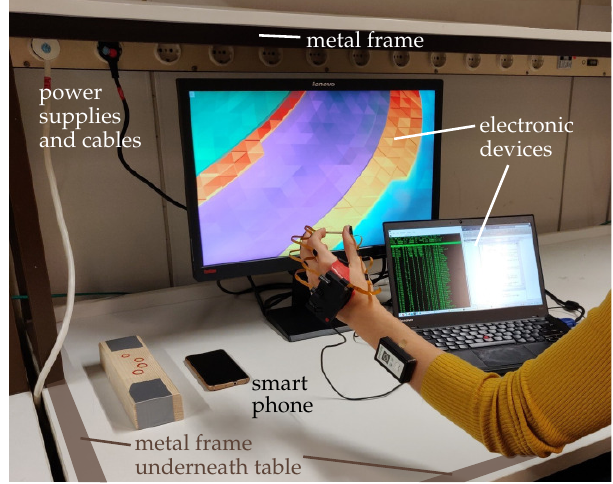
Figure 9. Measurement setup for Setting 2 in the direct presence of ferromagnetic materials and electronic devices.